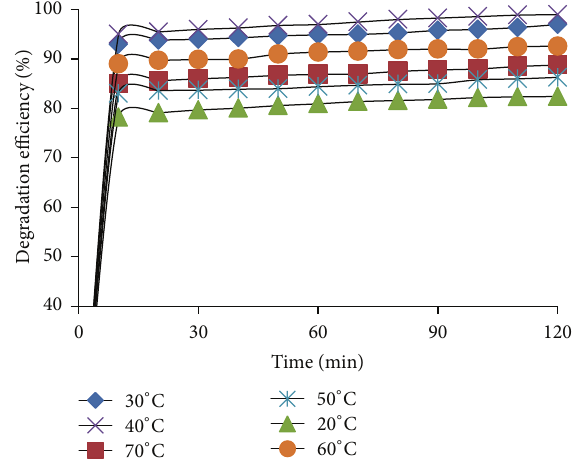
Figure 6: Effect of temperature on the discoloration efficiency for Fenton-like oxidation